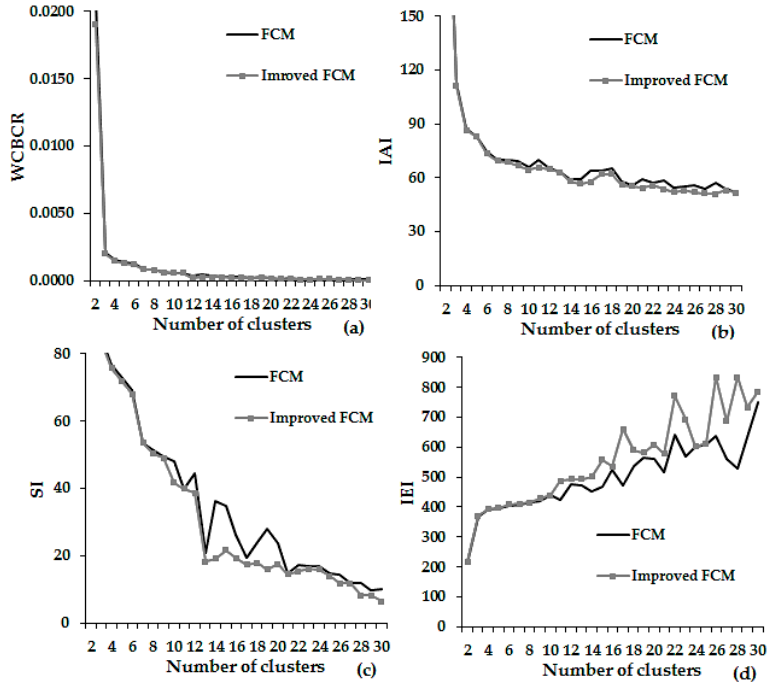
Figure 4. Comparison of the algorithms considering: ( a ) WCBCR; ( b ) IAI; ( c ) SI and ( d ) IEI indicators on the 2011 data set of consumer 1.